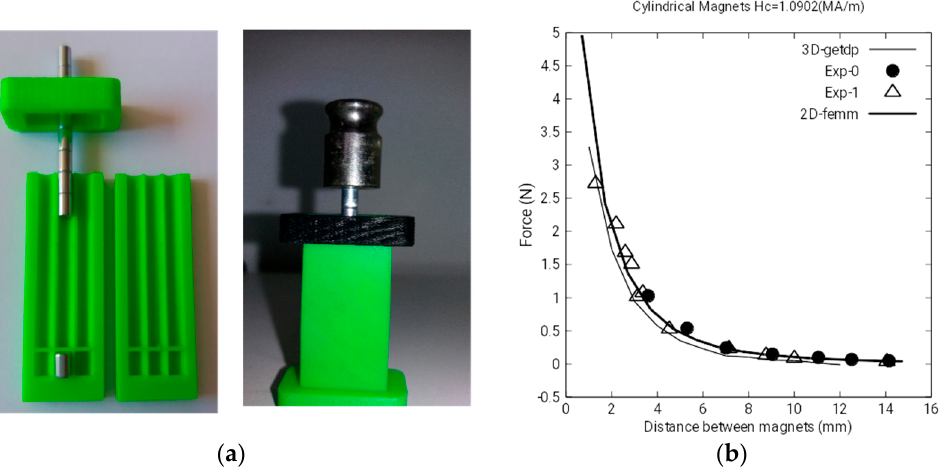
Figure 6. ( a ) Magnet arrangement with magnetic and mechanical equilibrium force; ( b ) reference magnet characterization.